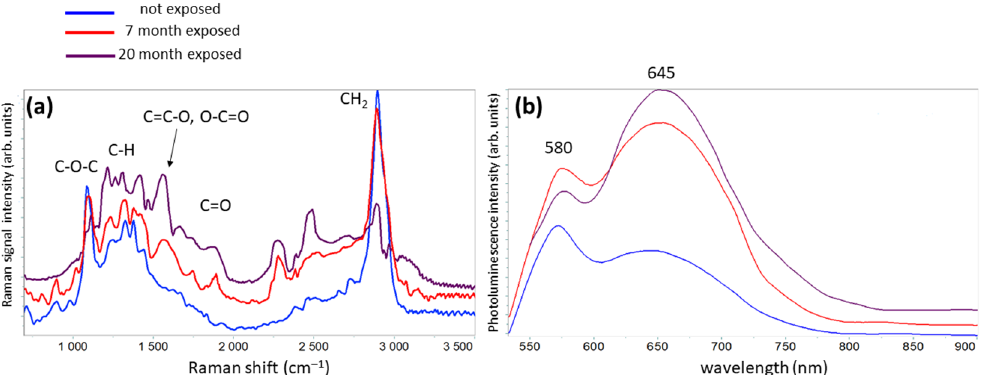
Figure 2. ( a ) Raman and ( b ) luminescence spectra acquired from paper sample before and after 7 and 20 months of exposition. 20 months of